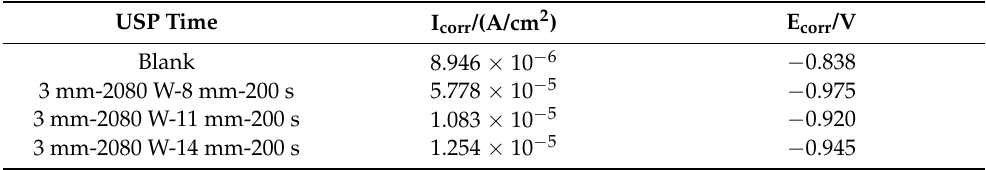
Figure 14. Electrochemical test polarization curves and line plot of the corrosion potential and corrosion current of samples with different USP distances. Table 7. The parameters of the equivalent elements in the equivalent circuit of the samples with different USP